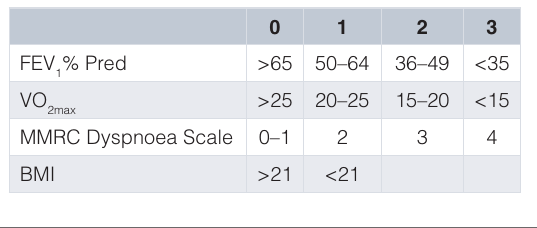
List of all unique study subject IDs (USUBJID) and demographic information including sex, age, COPD GOLD stage (if any), cigarette consumption (expressed as pack-years and cigarettes per day), study group (ARMCD), and the matching ID (MATCHID) allowing the pairing of control subjects to their ‘matched’ COPD subject.